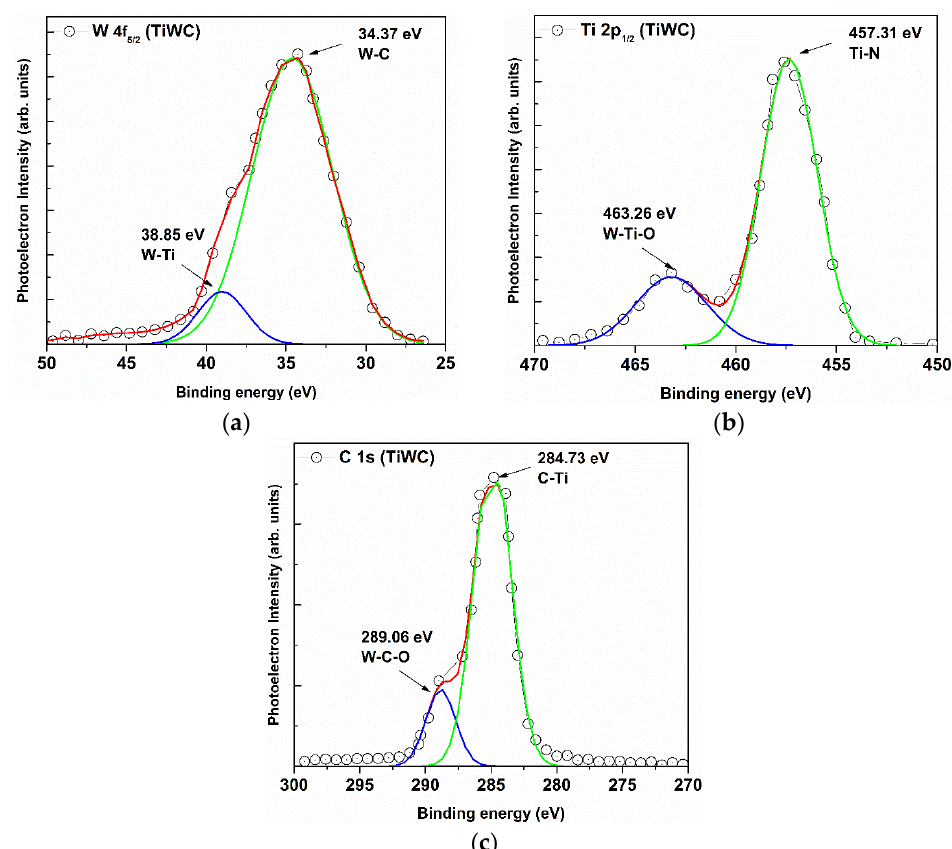
Figure 4. High resolution XPS spectra of Ti-W-C coating deposited by RF magnetron sputtering. ( a ) W (4f), ( b ) Ti (2p), ( c ) N (1s). Table 2. Chemical composition in atomic concentration (%) using XPS.